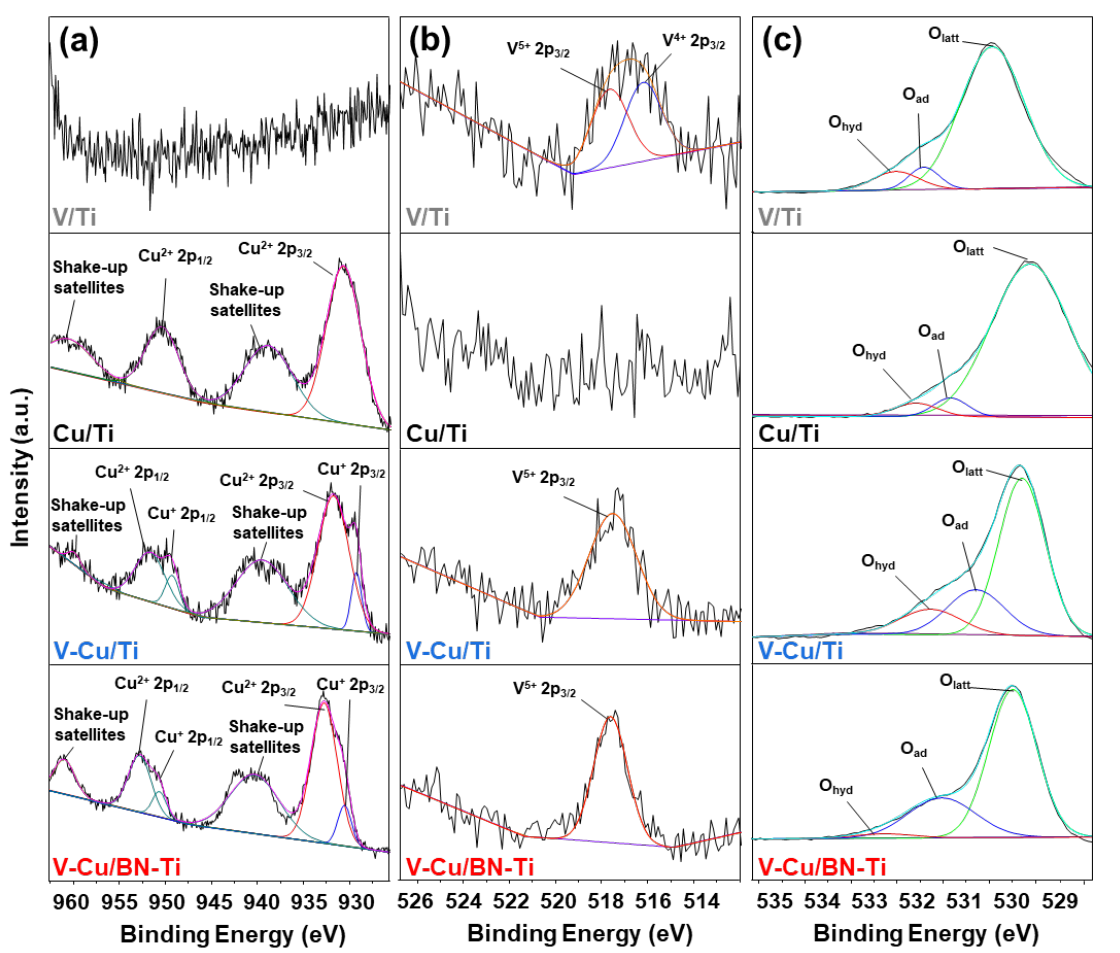
Figure 2. ( a ) Cu 2p, ( b ) V 2p, and ( c ) O 1s XPS spectra of the chemical states of the synthesized catalysts.